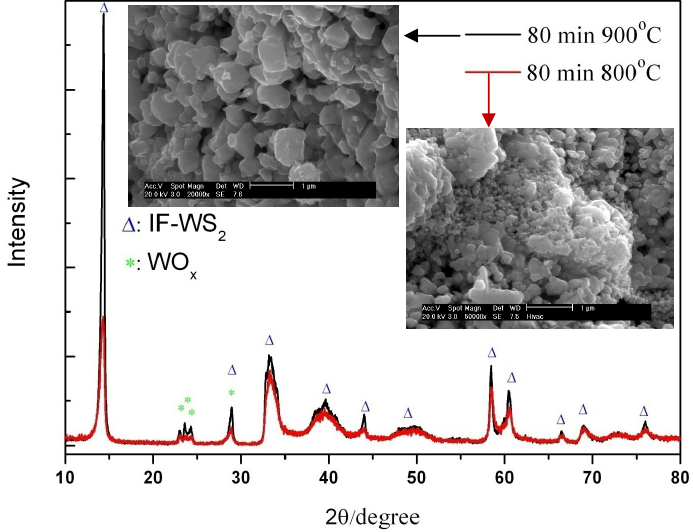
Figure 10. XRD profiles of samples from batch C (800 °C, red curve ) and G (900 °C, black curve ) and their SEM